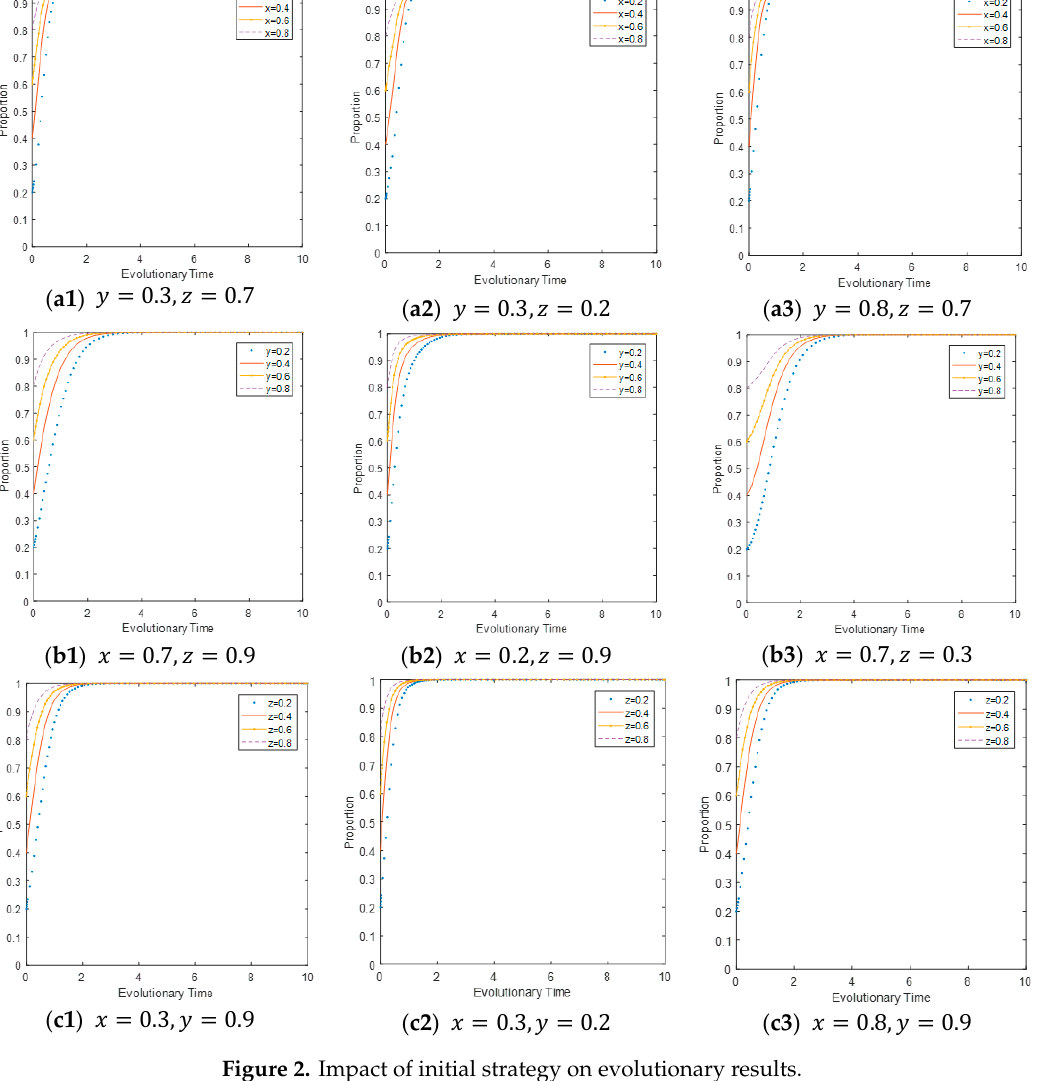
Figure 2. Impact of initial strategy on evolutionary